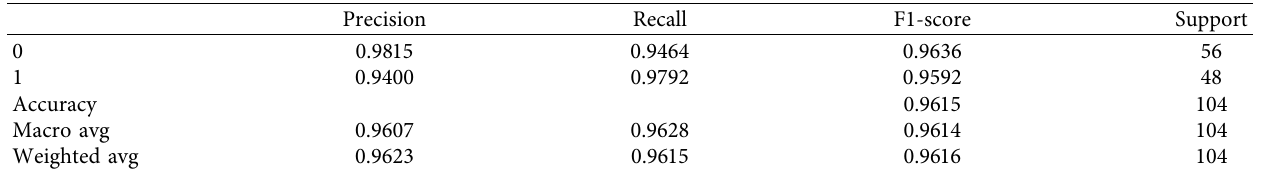
Figure 2: Snapshot of the output of the Tweepy code. Table 1: Generated classification report of the